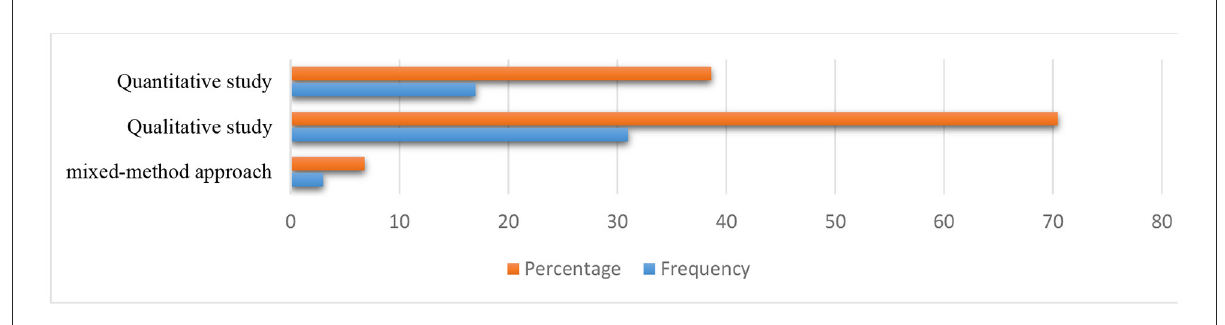
FIGURE4 Type of the